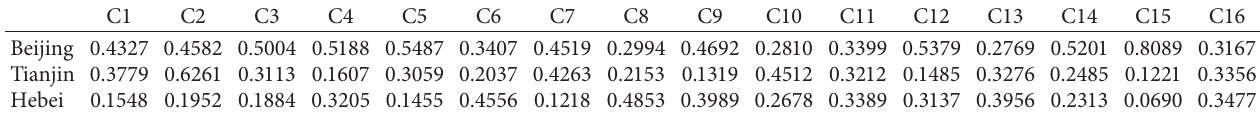
Table 3: The influencing factor values of Beijing-Tianjin-Hebei